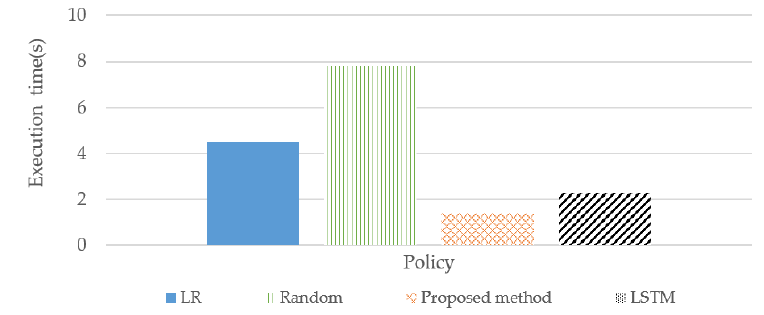
Figure 13. Execution time for case 1.